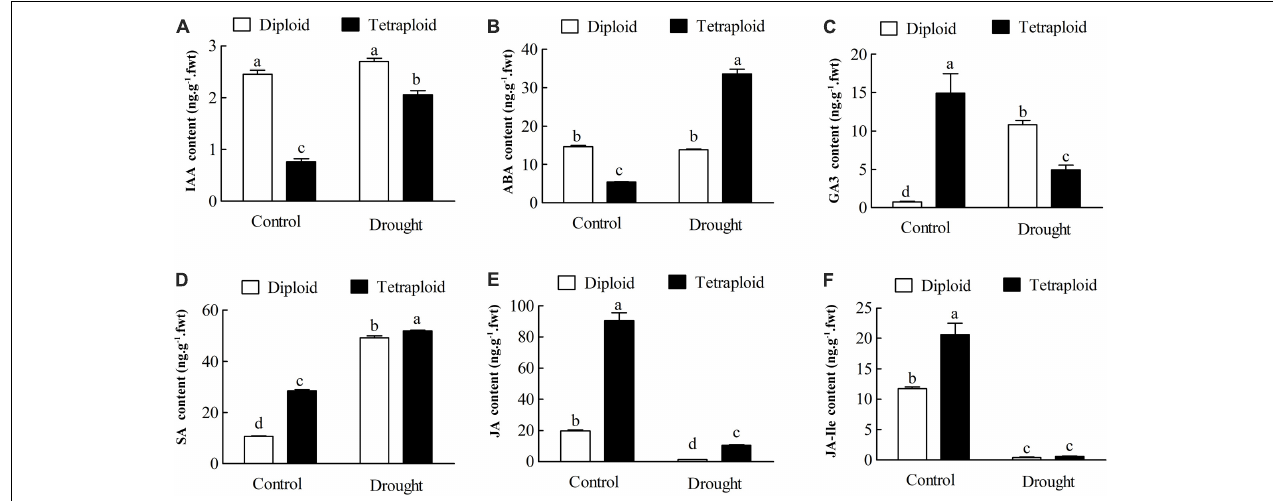
FIGURE 9 | The levels of phytohormone were determined by UHPLC-MS/MS in tetraploids and diploids Citrus wilsonii under drought stress. (A) IAA content; (B) ABA content; (C) GA3 content; (D) SA content; (E) JA content; (F) JA-Ile content. Each value is the mean of three biological replicates, and the vertical bars represent the standard errors. Values sharing the same lower case letters are insignificant as ANOVA at P <